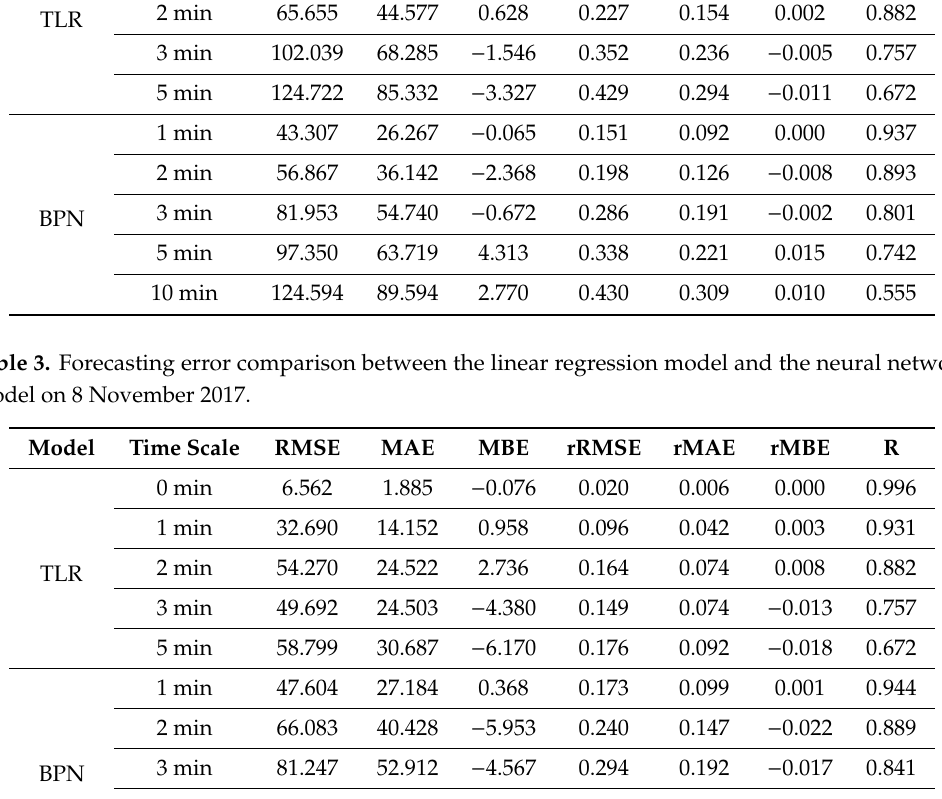
Table 1. Forecasting error comparison between the ternary linear regression (TRL) model and the back